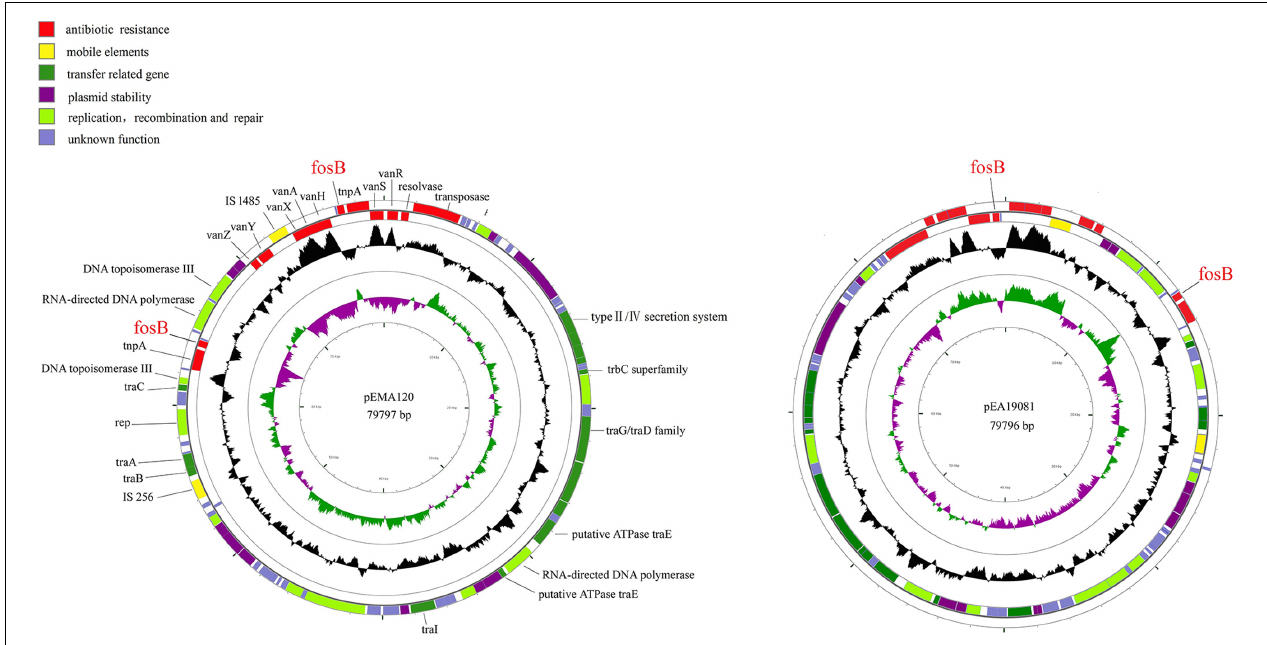
FIGURE 1 | Structure of plasmid pEMA120 and pEA19081. The two outer circles represent ORFs in the plus (outside) and minus (inside) orientations, respectively. Functions are color coded as explained in the key. The two inner circles represent the G + C content plotted against the average G + C content of 33.8% (black circle) and GC skew information (green and purple circles).